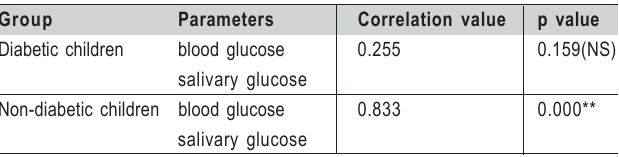
** - Correlation is significant at the 0.01 level (2-tailed)